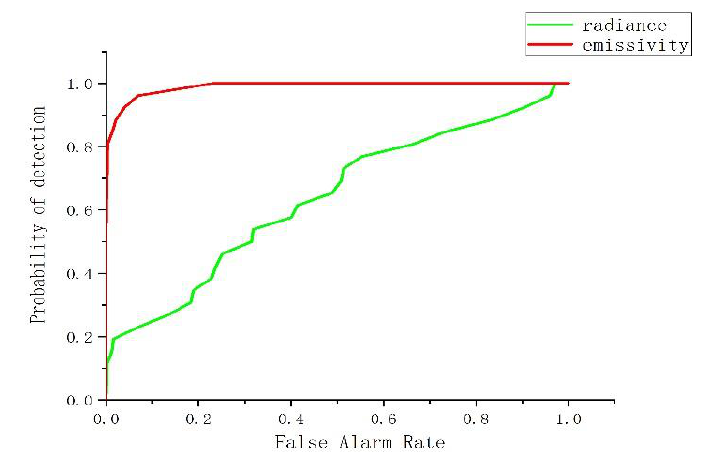
Figure 20. ROC curves of the metal plates data set.